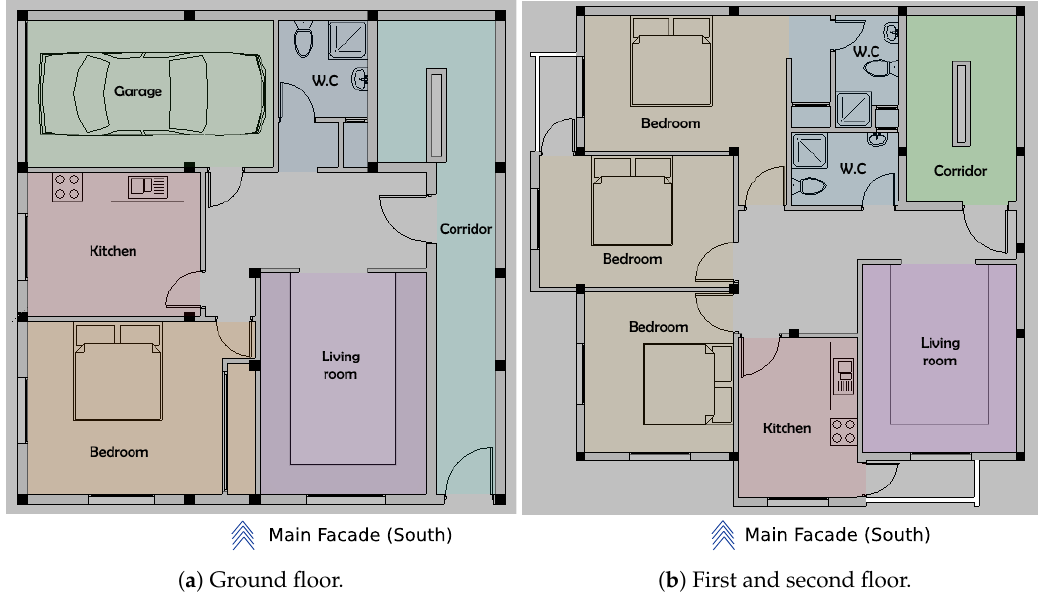
Figure 7. Building case study. General overview.